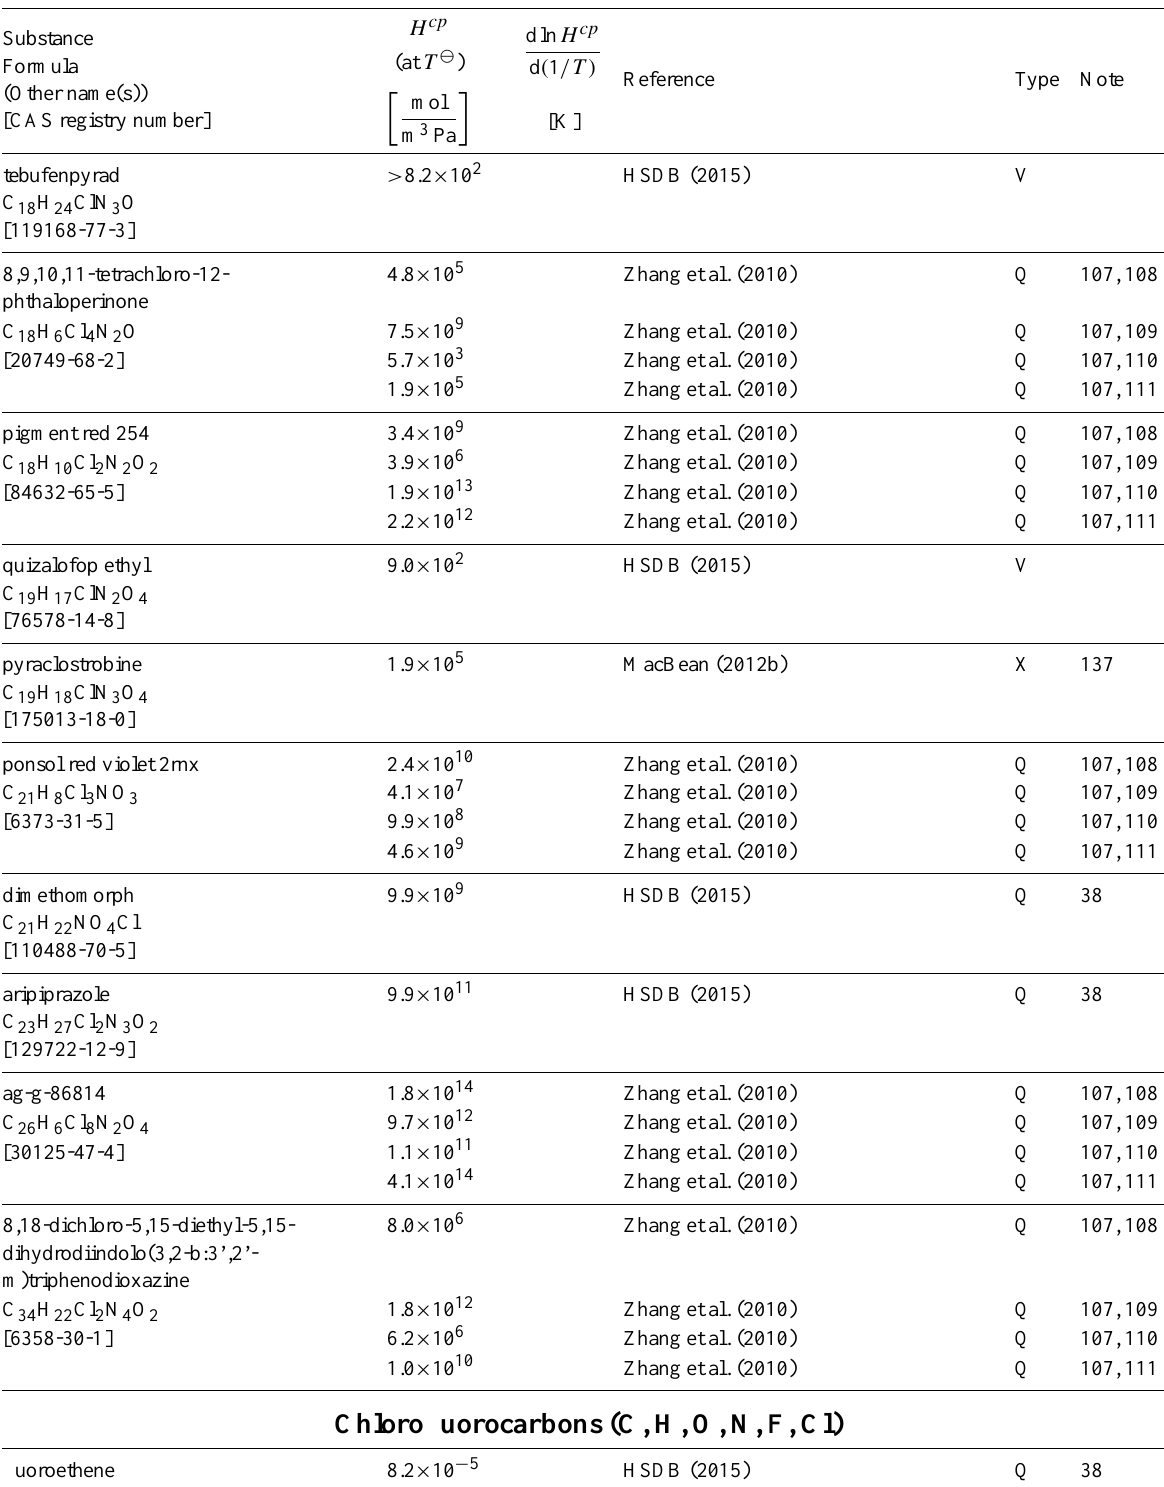
Table 6: Henry’s law constants for water as solvent